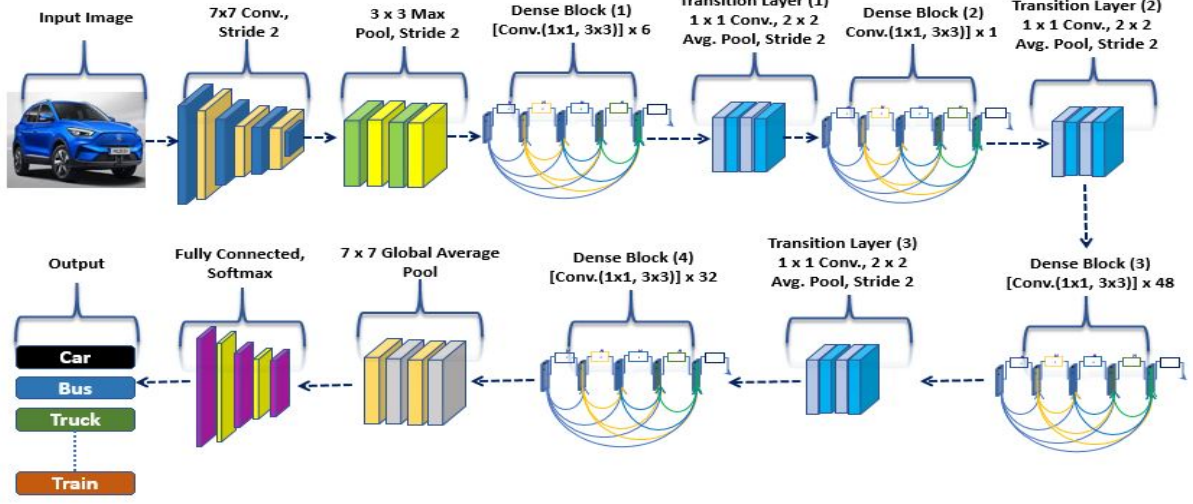
Figure 3. DenseNet201 architecture (feature extraction block).